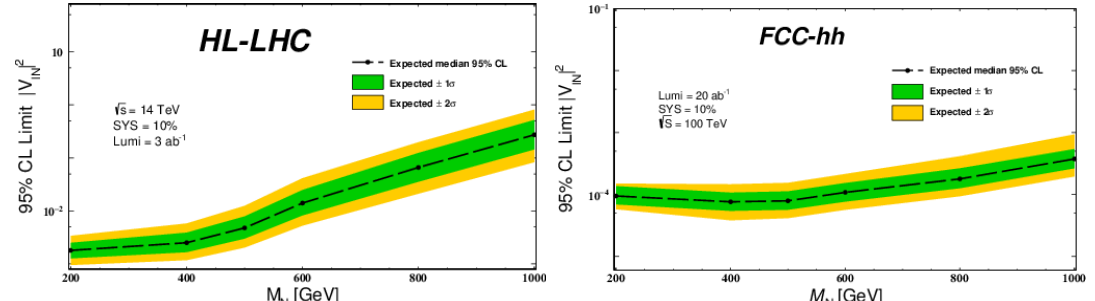
Figure 5 . Same as (cid:12)gure 4, including the 1, 2, 3 and 5- (cid:27) median expected limits on the production cross section times branching ratio (cid:27) ( pp ! l (cid:6) N ) (cid:2) BR( N ! l (cid:7) jj ) in fb at the HL-LHC (left) with p 3 ab (cid:0) 1 luminosity and at the FCC-hh (right) with s = 100 TeV and 20 ab (cid:0) 1 luminosity. In both panels the solid (dashed) line denotes that a 10% (0%) systematic uncertainty on the background is considered.